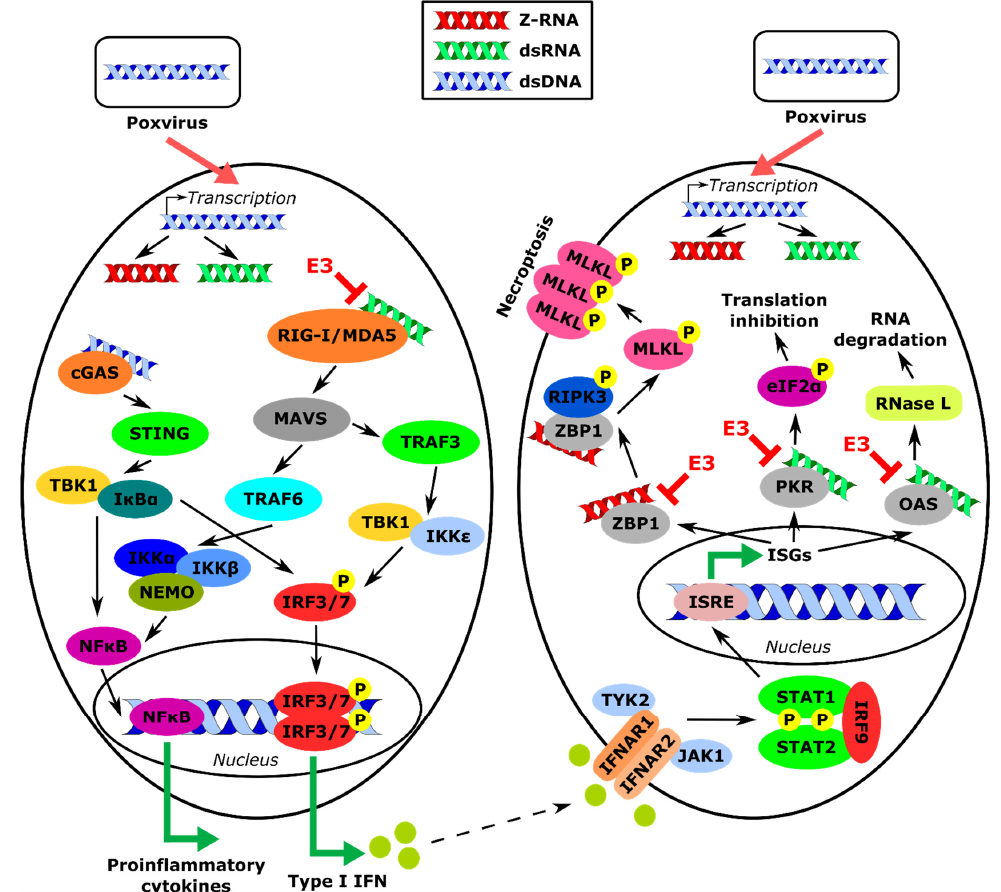
Figure 1. Summary of type I IFN response induction by poxviruses and its inhibition by VACV E3 protein. During poxviral infection, transcription of the viral genome results in the production of dsRNA and Z-RNA. Furthermore, dsRNA is sensed by cytosolic sensors RIG-I/MDA5 and cGAS, which induce a signaling cascade leading to the production of proinflammatory cytokines and type I IFN. IFN is sensed by neighboring cells, where it induces the expression of ISGs, including OAS, PKR, and ZBP1. Activation of OAS and PKR by dsRNA leads to RNA degradation and inhibition of translation, respectively. Activation of ZBP1 by Z-RNA results in induction of cellular death pathway necroptosis. The VACV E3 protein binds to dsRNA and thereby inhibits its recognition by RIG-I/MDA5 and cGAS (red text and red lines). E3 also inhibits activation of OAS and PKR by binding to dsRNA, and inhibits activation of ZBP1 by binding to zRNA. Abbreviations used in this figure include: eIF2 α : eukaryotic translation initiation factor 2 subunit alpha; IFN: interferon; IFNAR1/2: IFN alpha and beta receptor subunit 1/2; I κ B α : NF κ B inhibitor alpha; IKK α / β / ε : I κ B α kinase alpha/beta/epsilon; IRF3/7/9: interferon regulatory factor 3/7/9; ISG: IFN-stimulated gene; ISRE: IFN-sensitive response element; JAK1: Janus kinase 1; MAVS: mitochondrial antiviral-signaling protein; MDA5: melanoma differentiation-associated protein 5; MLKL: mixed-lineage kinase-like; NEMO: NF κ B essential modulator; NF κ B: nuclear factor of kappa-light-chain-enhancer of activated B-cells; OAS: oligoadenylate synthetase; PKR: protein kinase dependent on RNA; RIG-I: retinoic acid-inducible gene I; RIPK3: receptor-interacting protein kinase 3; STAT1/2: signal transducer and activator of transcription 1/2; STING: stimulator of interferon genes; TRAF3/6: tumor necrosis factor receptor-associated factor 3/6; TBK1: TRAF family member-associated NF κ B activator (TANK)- binding kinase 1; TYK2: tyrosine kinase 2; ZBP1: Z-DNA-binding protein